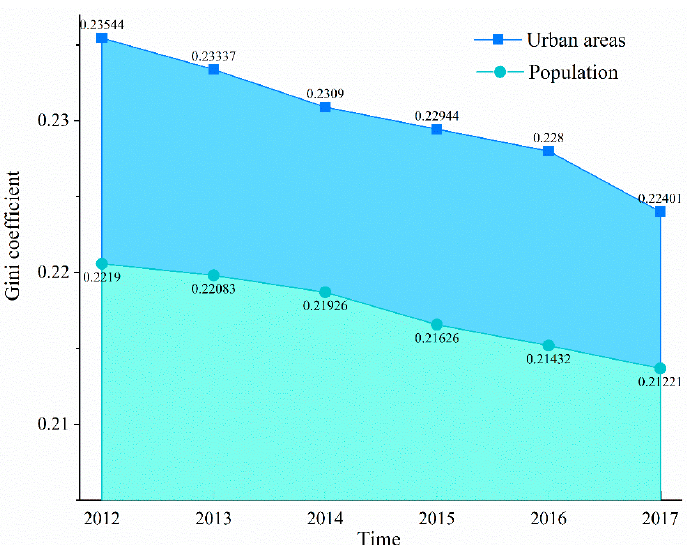
Figure 8. Variations in the Gini coefficient for extracted urban areas and the statistic population data of YRD from 2012 to